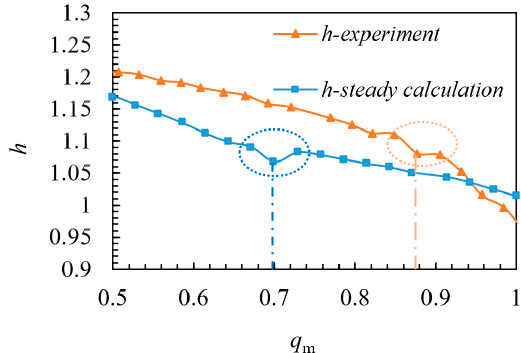
Figure 5. Calculation feasibility verification. Table 2. Key characteristic parameters at design point under pump condition.